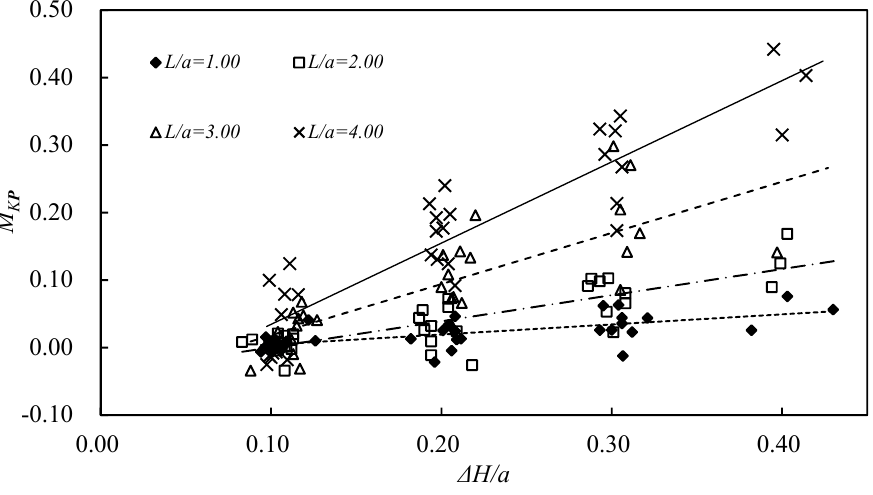
Figure 8. M KP vs. ∆ H/a for L/a = 1.00, 2.00, 3.00 and Figure 8. M KP vs. Δ H/a for L/a = 1.00, 2.00, 3.00 and 4.00.